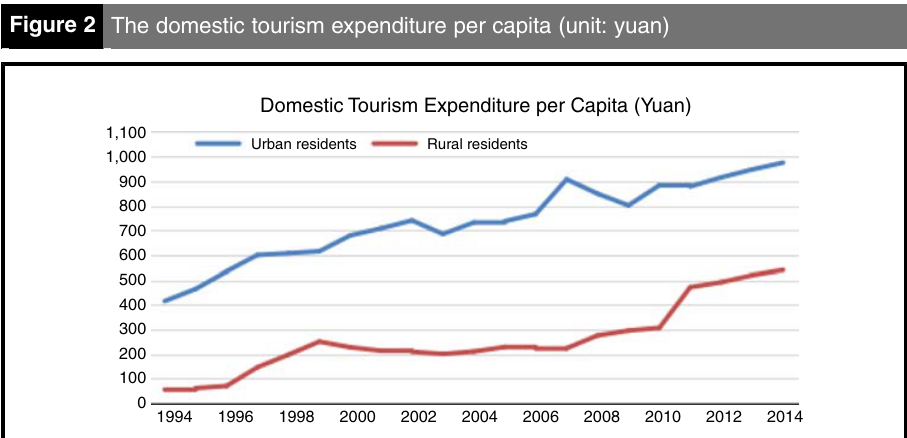
Figure 2 The domestic tourism expenditure per capita (unit: